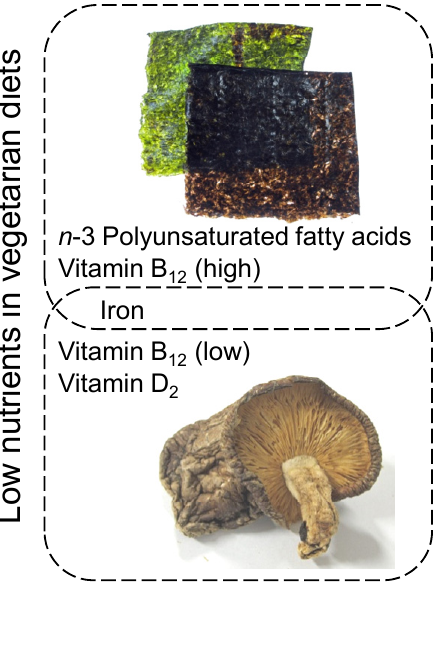
Figure 4. Proposed method for improving nutrient imbalance in vegetarian diets using dried purple laver as a Vitamin B source in addition to other plant-based food 12